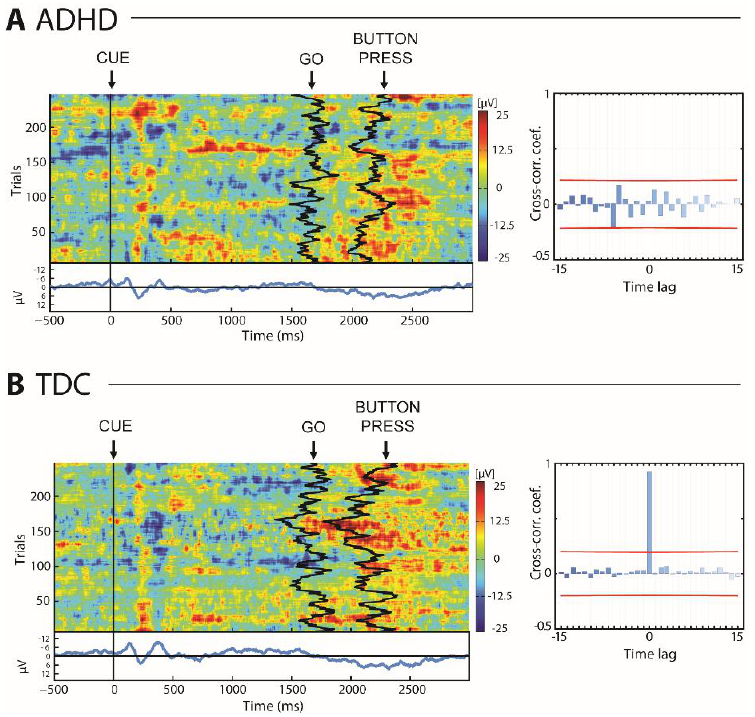
Figure 2. Reaction time in attention-deficit/hyperactivity disorder (ADHD) ( A ) and typically developing children (TDC) ( B ) groups, including cross-correlation between occurrence of Go and PB stimuli. Red line indicates significance p < 0.05.